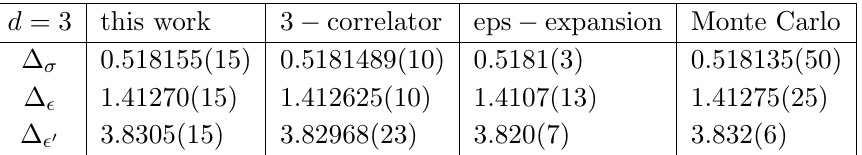
Table 4 . Comparison of d = 3 results for low-lying (cid:12)elds from bootstrap data of this work and the three-correlator analysis [13], resummed epsilon expansion [17] and Monte Carlo [18].